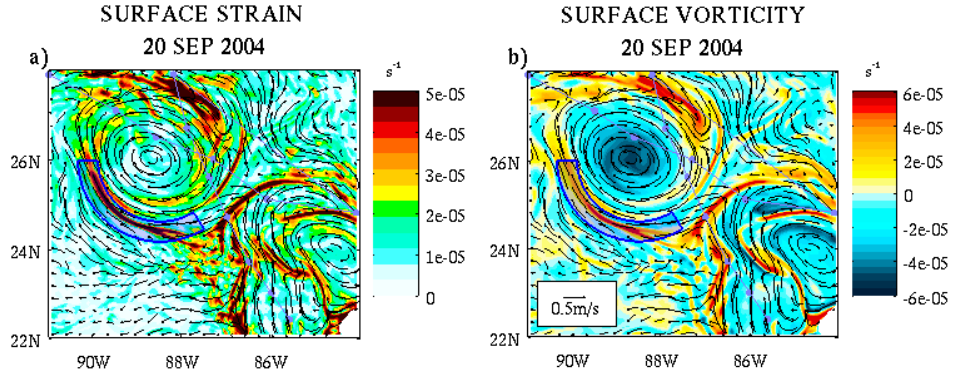
Figure 4. ( a ) Surface strain (s − 1 ) at the surface for 0000 UTC 20 September 2004 and ( b ) Surface vorticity (s − 1 ) at 0000 UTC 20 September 2004. Vectors represent surface currents’ strength and direction. Hurricane Ivan track is indicated by the dark purple line, with waypoints at each 0000 and 1200 UTC location. The blue shaded area represents the primary area of interest including, and surrounding, the filament.